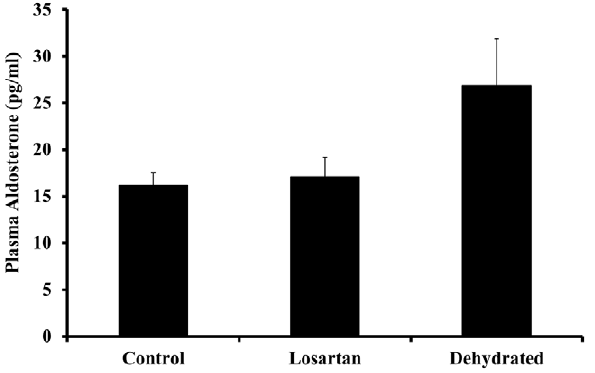
Figure 2. Plasma aldosterone in non-dehydrated (‘‘control’’, n=6), Losartan treated (n=6), and dehydrated camels (n=18) on day 20 of dehydration. Data are shown as mean 6 SEM. Changes in aldosterone level in dehydrated camels is not statistically significant compared to control camels.